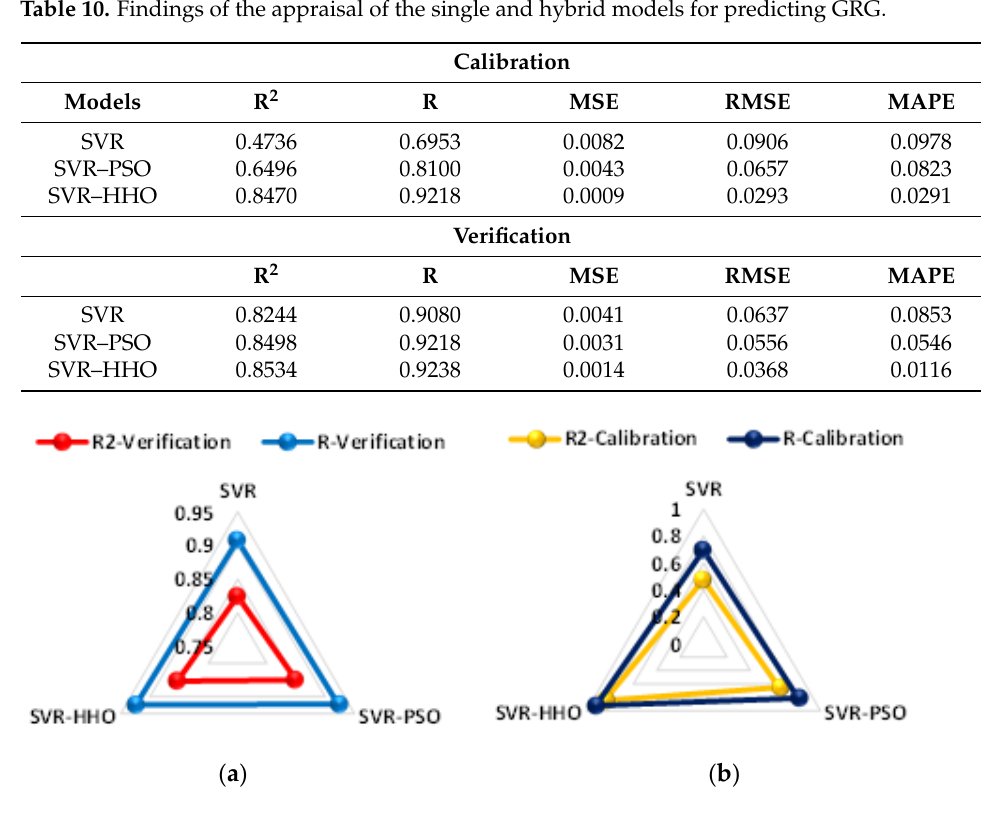
Figure 19. Radar plot for GRG in the ( a ) calibration and ( b ) verifications stages.